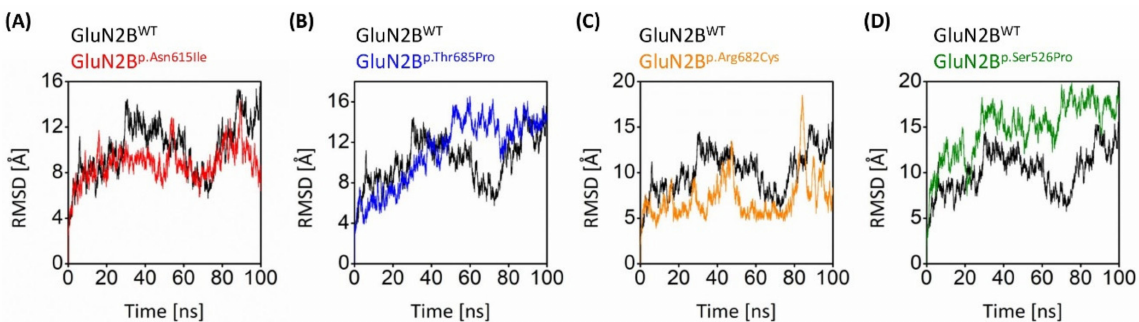
Figure 4. RMSD plot manifesting the collective conformational drifts in both GluN2B WT and GluN2B MT models. RMSD comparison of native GluN2B with ( A ) GluN2B p.Asn615Ile , ( B ) GluN2B p.Thr685Pro , ( C ) GluN2B p.Arg682Cys , and ( D ) GluN2B p.Ser526Pro